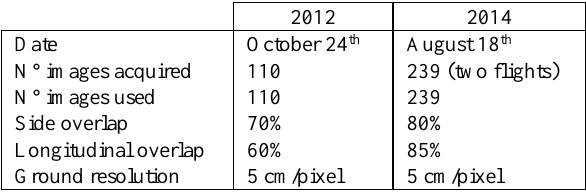
Table 1. Summary of the UAS flights characteristics.